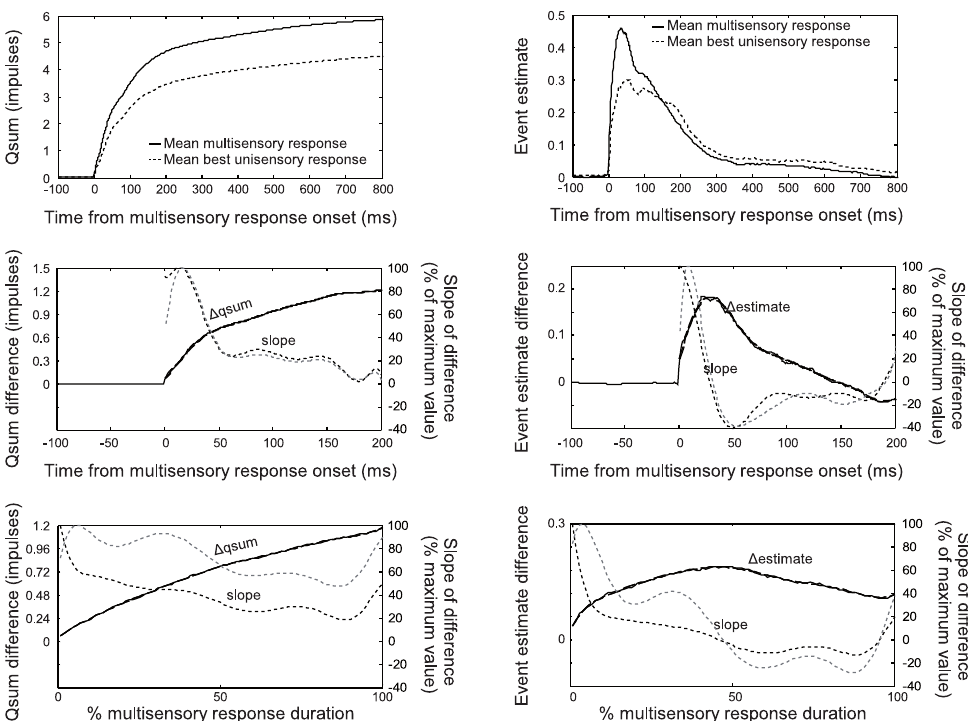
Figure 4. The temporal profile of multisensory enhancement . Multisensory and best (i.e., largest) unisensory responses are quantified as qsums (left) or event estimates (right), shifted to synchronize with the multisensory response onset, then averaged across data samples. Average multisensory qsums and event estimates reached higher values than the corresponding best unisensory responses (top). Subtracting the multisensory and unisensory responses and averaging across samples yielded mean difference functions (middle, black lines). The mean difference functions were fit with 10th-order polynomials, illustrated with dashed black lines but virtually invisible given the closeness of the fit. The derivatives of these functions are illustrated by dotted lines and scaled proportional to their maximum value (read off right axis). Darker lines indicate the slope of the function fit after averaging across samples. Lighter lines indicate the slope fit to the individual data samples and then averaged. Slopes show a general decreasing trend. Normalizing these functions for different values of response duration (bottom) revealed the same overall trend: enhancements were high at the beginning of the response, and decreased rapidly within 40ms or 50% of the total response duration. However, enhancement continued throughout the response.